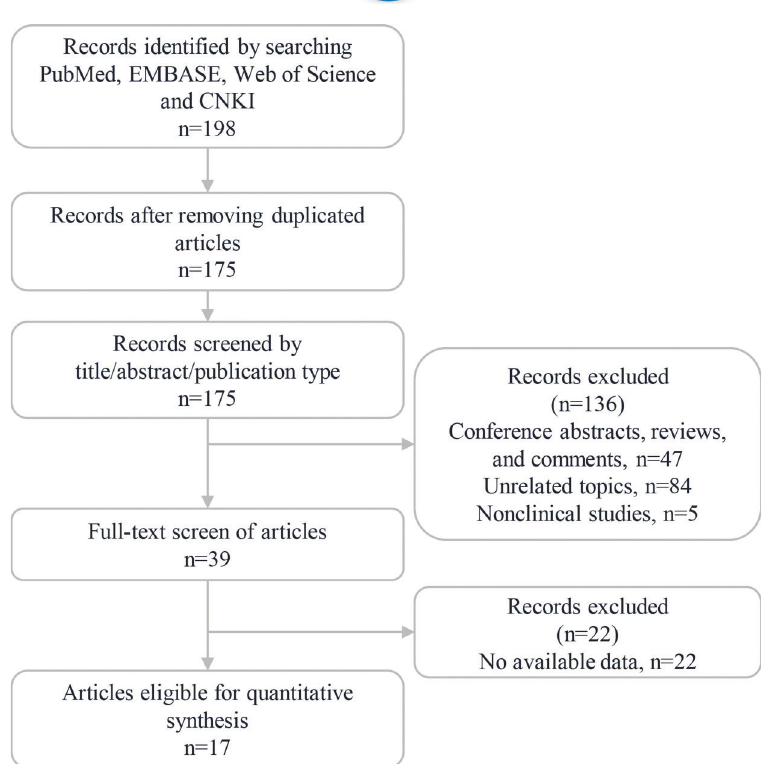
Figure 1 - Flow diagram of the literature identification